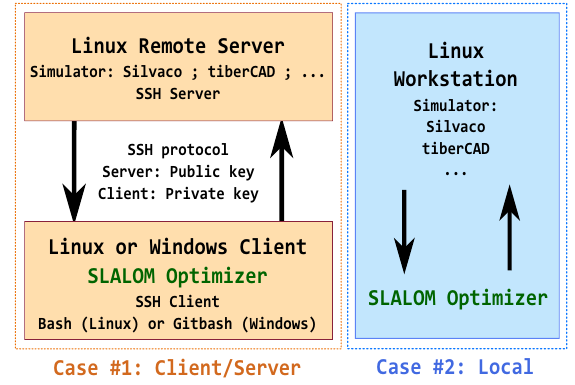
Fig. 3. The SLALOM optimizer